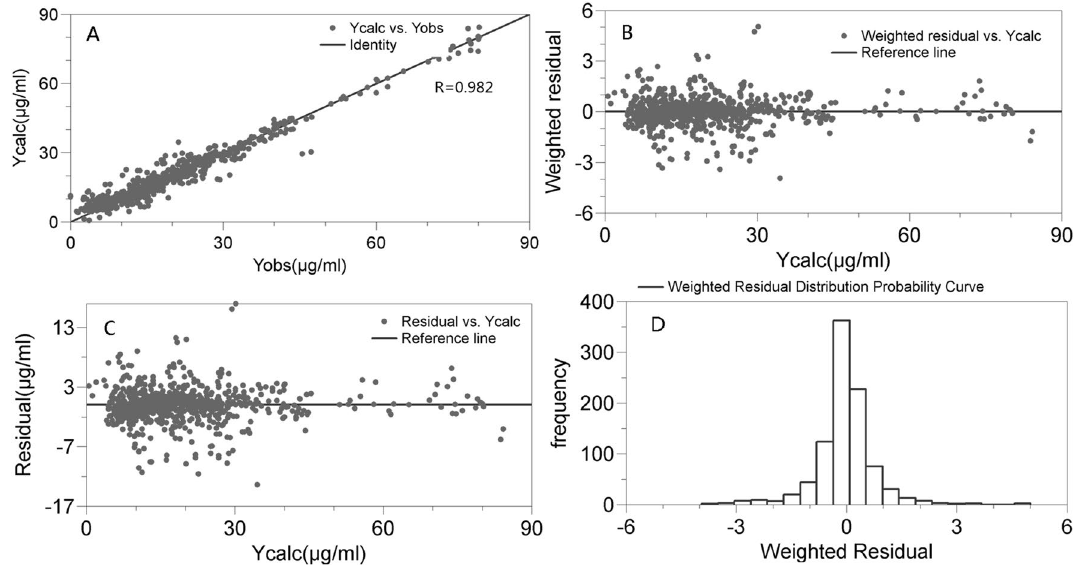
Figure 1. Goodness-of-fit plots of the final model for vancomycin. ( A ) Individual predictions of vancomycin versus observed concentrations. ( B ) Individual predictions of vancomycin versus predicted weighted residuals. ( C ) Individual predictions of vancomycin versus predicted residuals. ( D ) Gaussian distribution of weighted residuals.